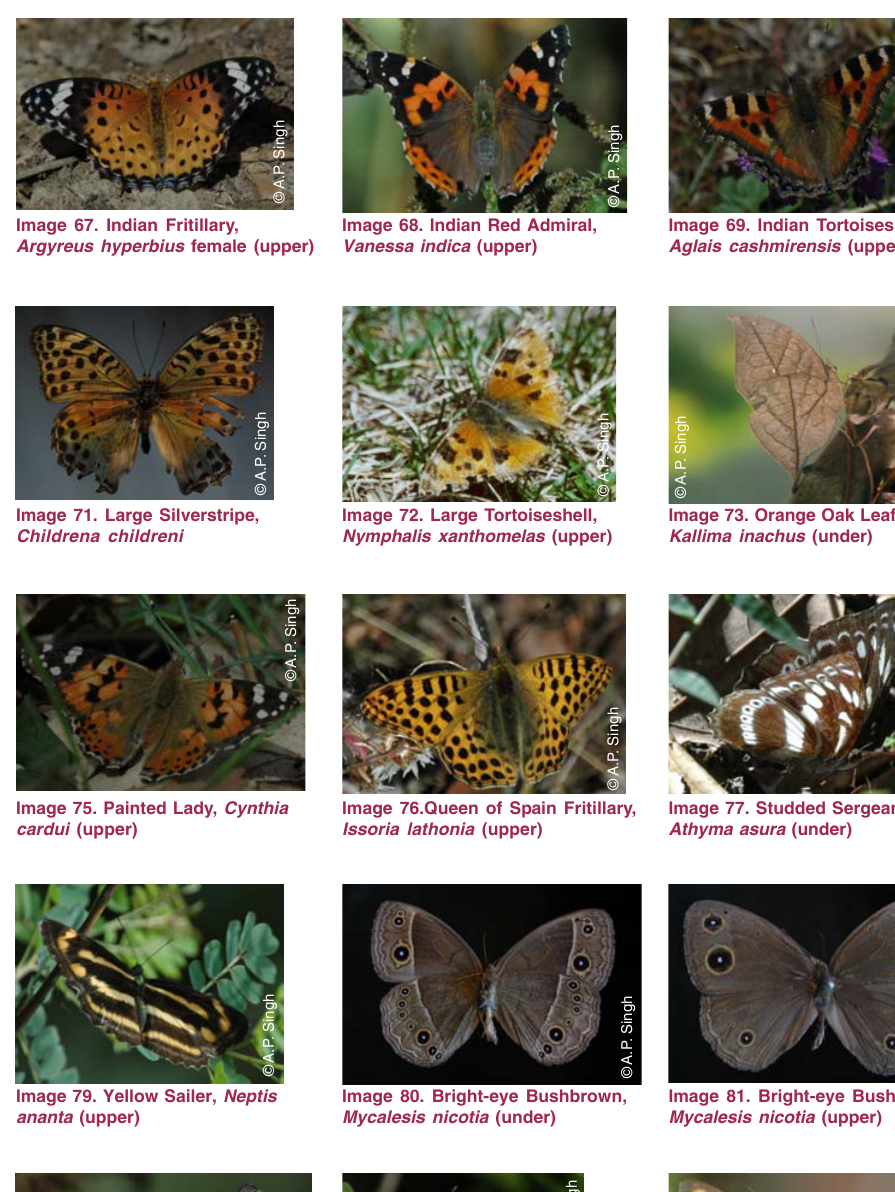
Image 79. Yellow Sailer, Neptis ananta (upper)